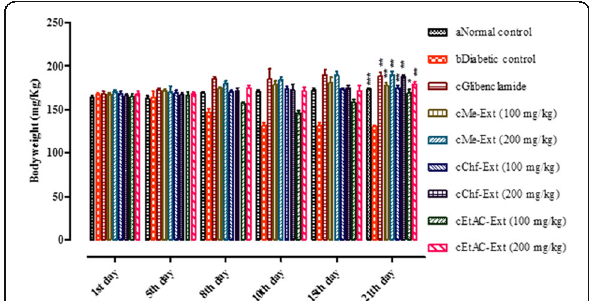
Fig. 5 Effect of E. umbellata fruit methanolic extracts/fractions and glibenclamide on blood glucose level in STZ-induced diabetic rats. Each value is Mean±SEM of 8 animals. Comparisons were made between a normal control to b diabetic control using student t-test (*** P < 0.001) and between b diabetic control to positive control c (Glibenclamide/ extracts treated groups) using one way ANOVA followed by Dunnett ’ s multiple comparison test (* P < 0.05, ** P < 0.01, *** P < 0.001)